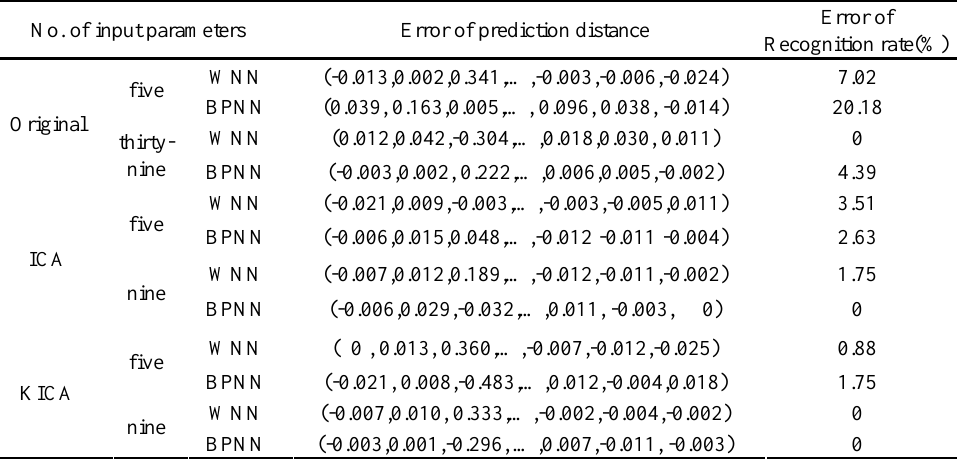
Table 4. Errors of testing